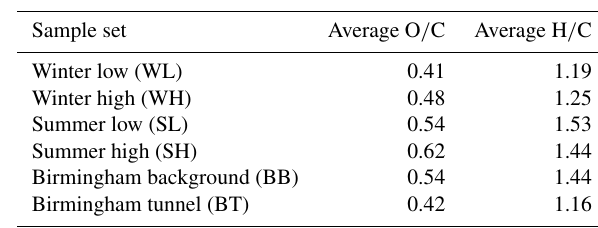
Table 1. Average O / C and H / C ratios for each sample